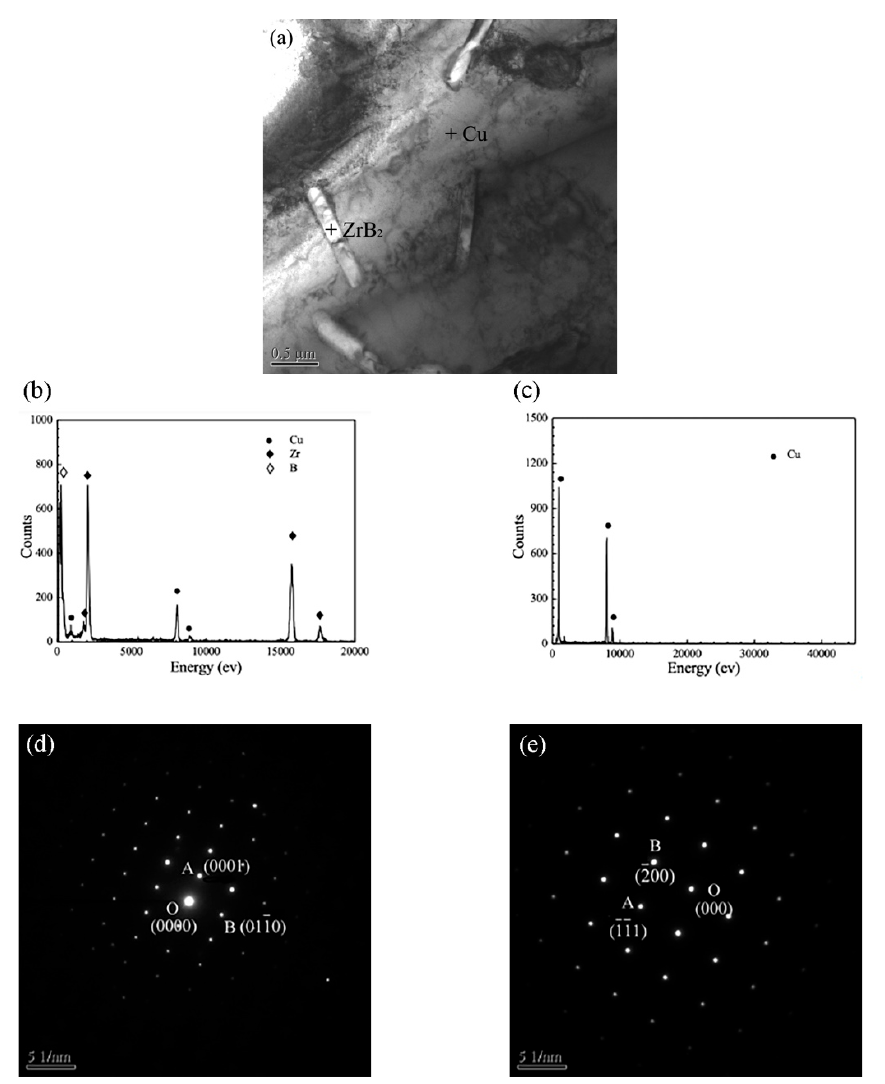
Figure 8. ( a ) TEM images of the composites (20 wt%, 53.33 kJ/cm 2 ). EDX of ( b ) ZrB 2 and ( c ) Cu. Selected area diffraction patterns of ( d ) small-sized secondary ZrB 2 and ( e ) Cu.